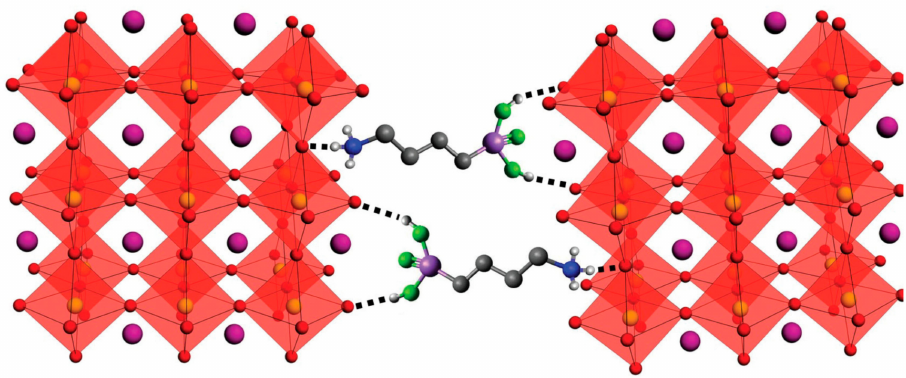
Figure 14. Schematic illustration of inter-connected two neighbouring grain structures by additives. Reproduced with permission from Ref.